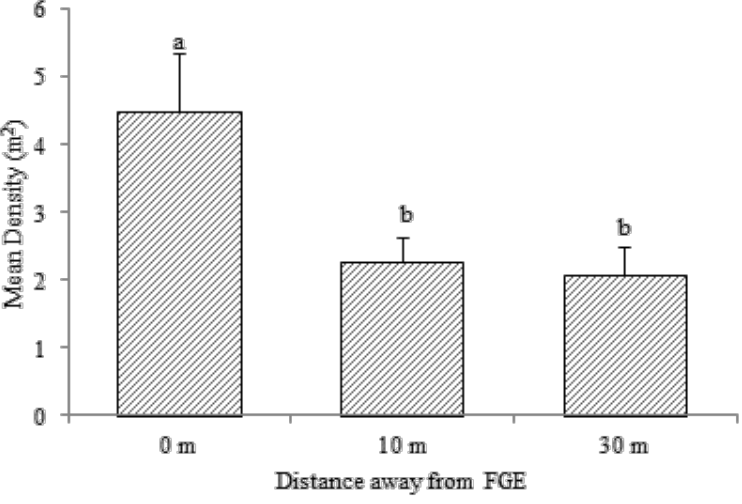
Figure 4: Total (mature plants, seedlings and saplings), seedlings and saplings abundance of Austroeupatorium inulifolium in the standing vegetation at different distances starting from the forest-grassland edge (0 m) and 10 m and 30 m away from the FGE towards the open grassland. Vertical bars represent standard error of the means